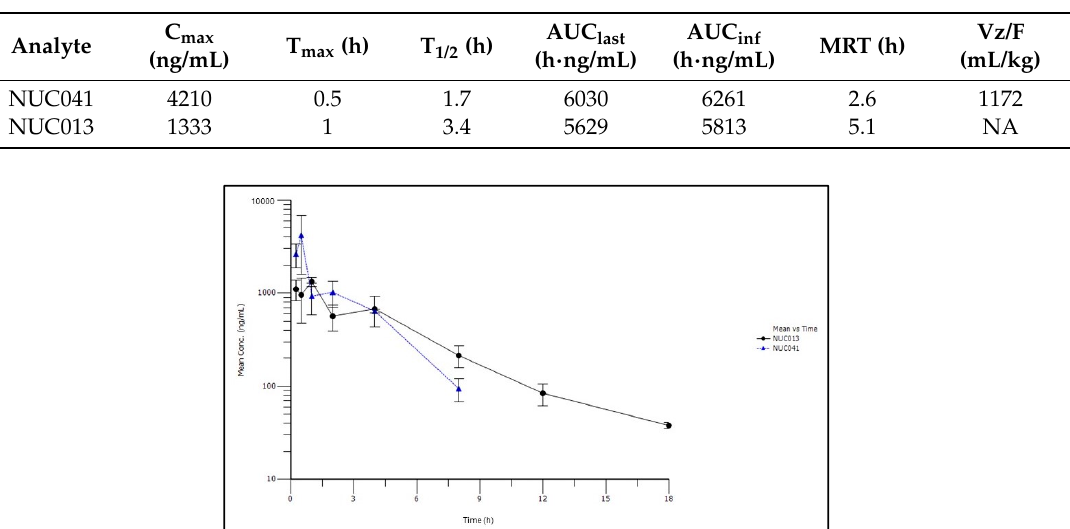
Table 3. Pharmacokinetic parameters derived from mean concentrations of NUC-041 and NUC-013 in whole blood following IM administration of NUC-041 (3 mg/mouse) formulated in PPD. Abbreviations as per Table 2, except MRT: Mean residence time. Vz/F: Apparent volume of distribution during terminal phase after non-intravenous administration.